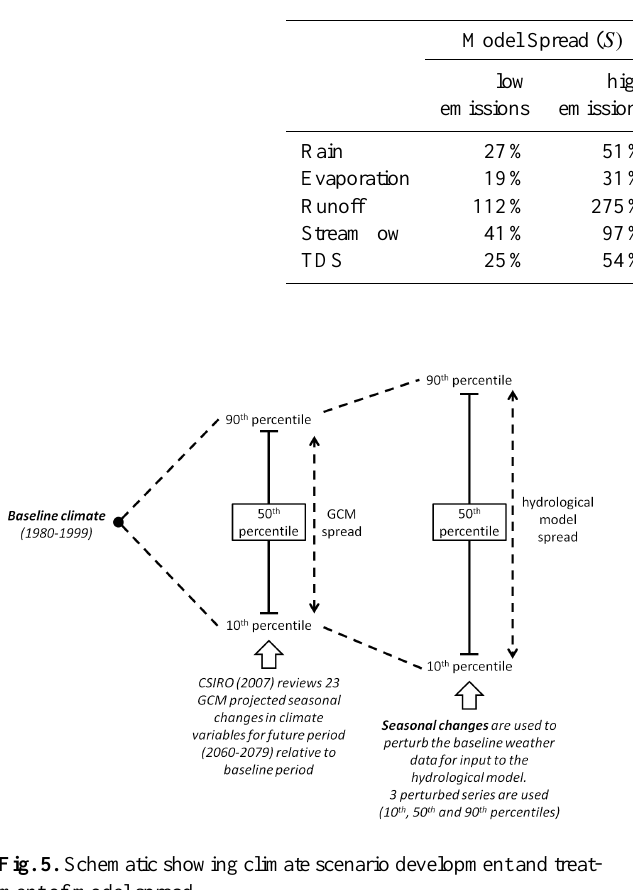
Table 5. Model spread and proportional change.